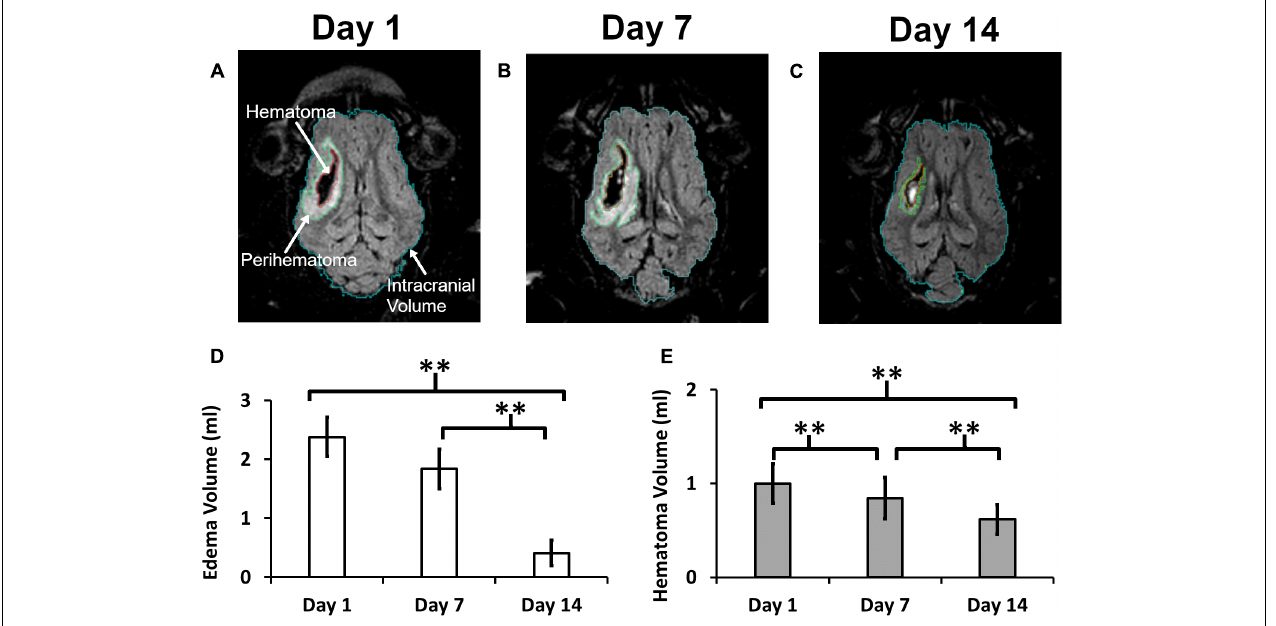
FIGURE 1 | A quantitative summary of the change in hematoma and edema volume in a post-ICH pig brain. Panels (A–C) illustrate a representative MRI image showing outlined boundaries of intracranial volume, perihematoma, and hematoma at days 1, 7, and 14, respectively. Panels (D,E) show Perihematoma edema (D) and hematoma (E) volumes. A double asterisk ( ∗∗ ) denotes the significant temporal ipsilesional difference between the time point ( p < 0.05). The error bars represent standard error in the